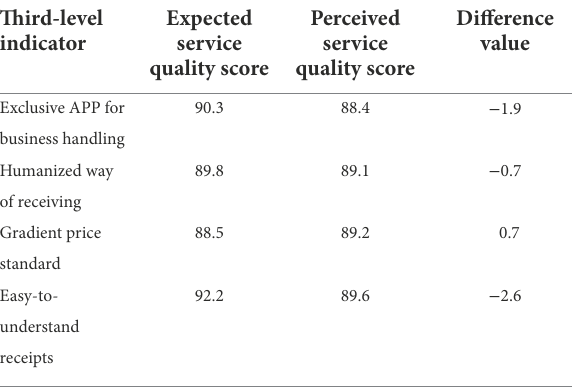
TABLE 7 Empathy corresponds to the three-level index score.